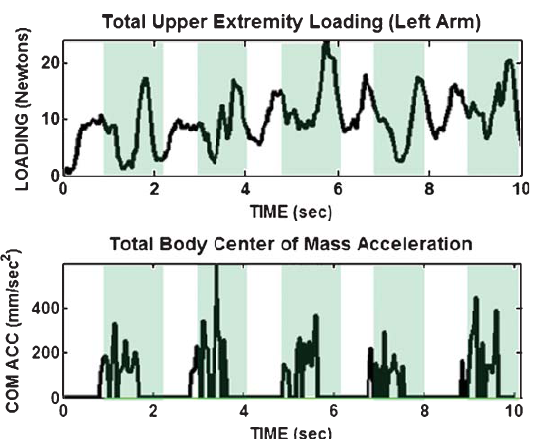
Fig. 3. TOP: Changes in left-side upper extremity (UE) loading to stabilize during five consecutive slide-shifts in anterior-posterior direction. BOTTOM: Corresponding estimate of center of mass acceleration and tracking period (light trace). Note : Accelerations <100mm/sec 2 displayed as zero. Shift periods denoted by shaded